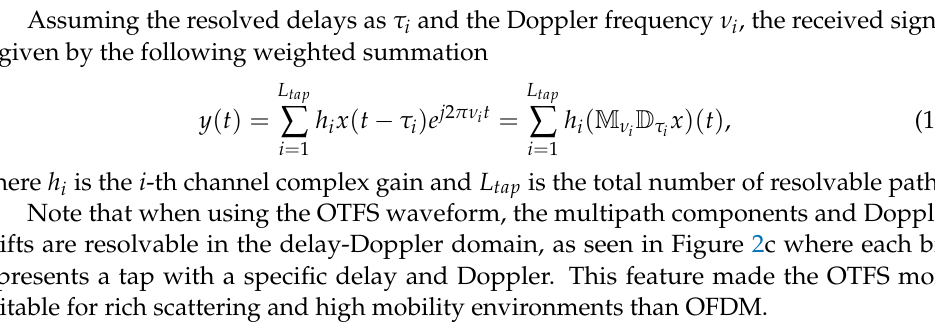
Figure 6. BER performance comparison between OTFS waveform with M = 32, N = 32 and OFDM waveform with N = 1024 affected by the Doppler shift using on the central frequency is 5 GHz reverberation